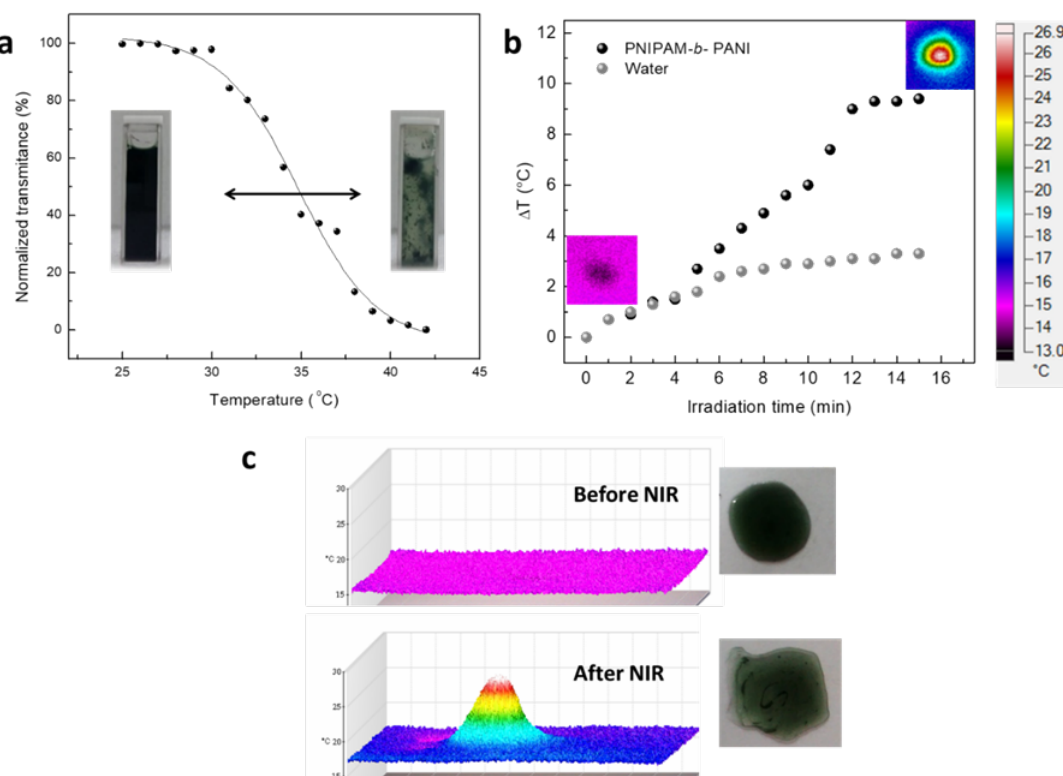
Figure 5. Material characterization of PNIPAM- b -PANI. ( a ) Turbidimetry as temperature function in aqueous solution; ( b ) photothermal effect on drop of PNIPAM- b -PANI aqueous solution under Near Infrared (NIR) irradiation; ( c ) optical and 3D infrared photograph of an aqueous drop containing the copolymer before and after NIR irradiation.